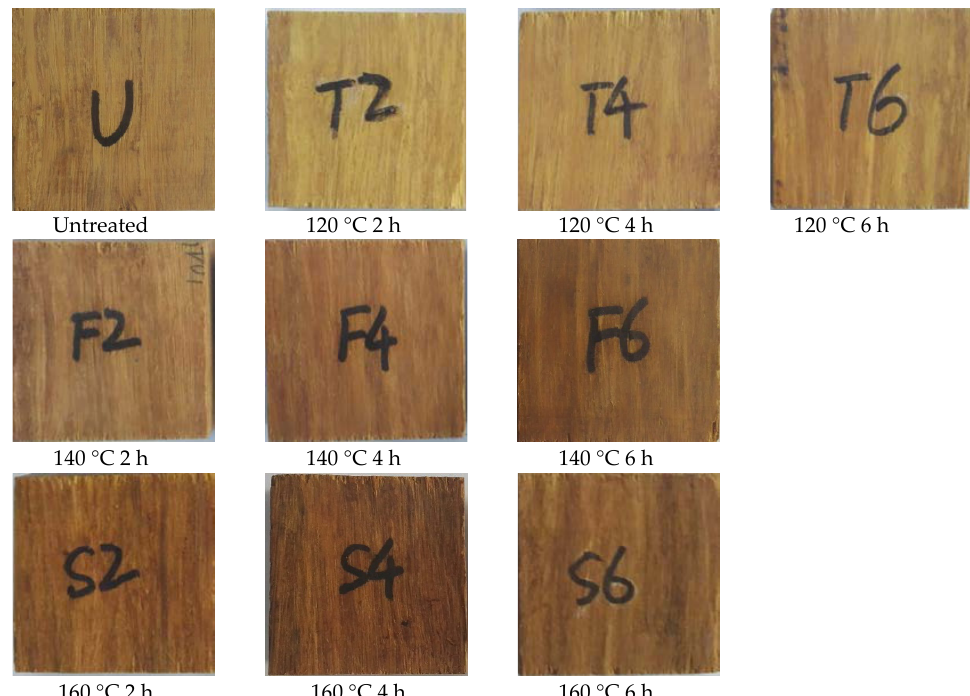
Figure 5. Digital photographs of bamboo scrimber before and after hot oil treatment. Table 1. The color index of bamboo scrimber after hot oil treatment.